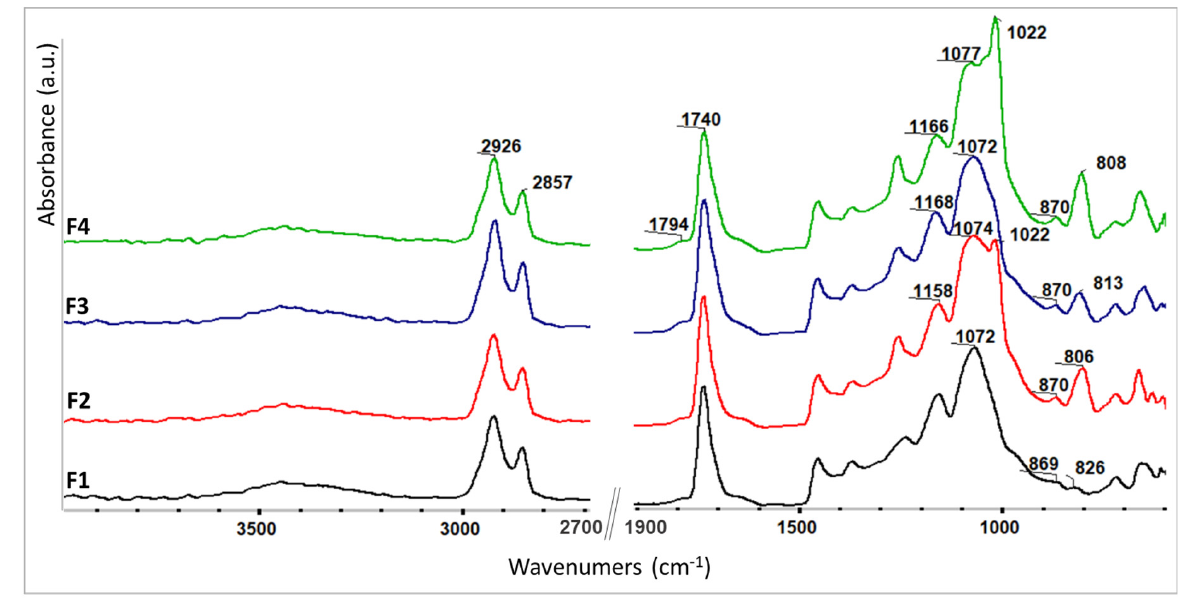
Figure 5. FTIR spectra of the final F1-F4 materials (after UV treatment). Table 3. GF, CA, WA